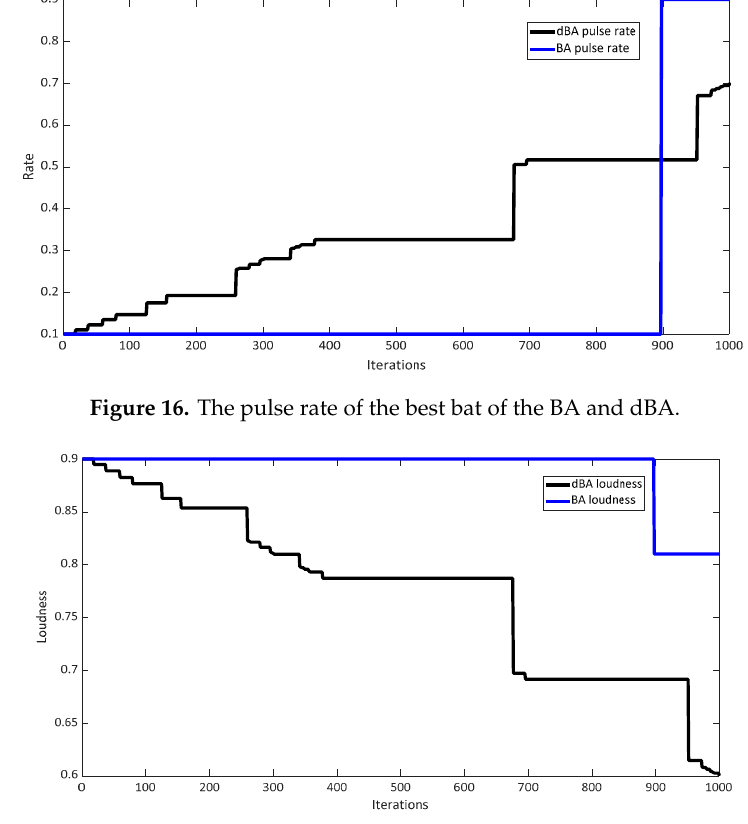
Figure 17. The loudness of the best bat of the BA and dBA.